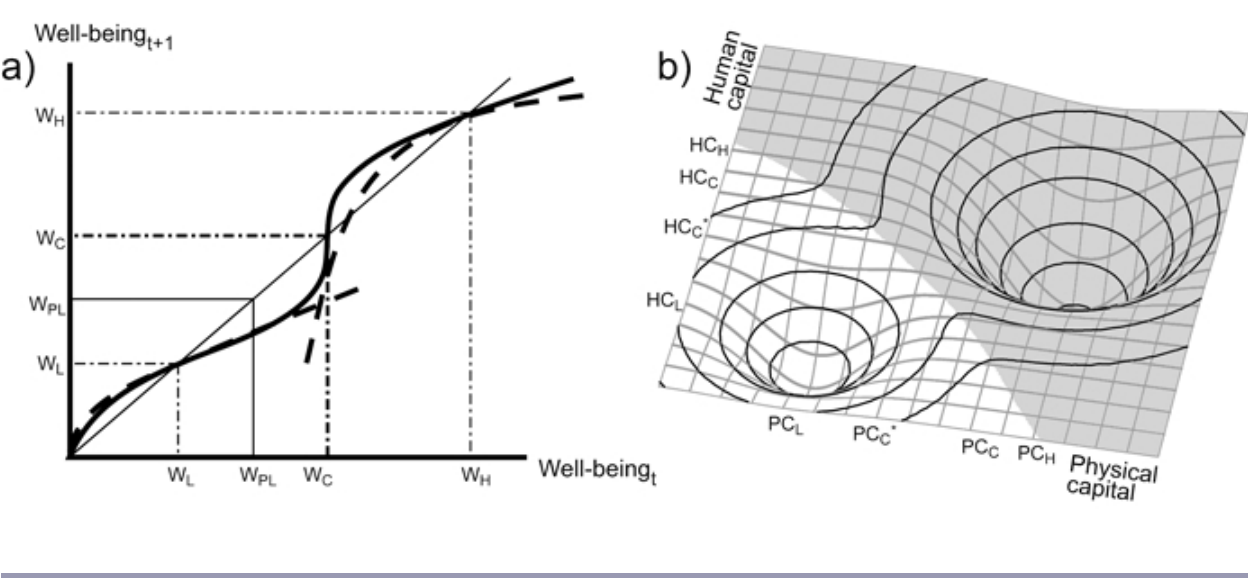
Fig. 3 . Figure 3(a) reproduces Barrett and Swallow’s (2006) figure on well-being dynamics under the poverty trap hypothesis for comparison with the new extended figure provided in 3(b). Figure 3(b) generalizes the approach to multiple forms of capital, which interact to create two self-reinforcing stable states at different equilibrium levels of capital. Vitally, 3(b) illustrates that improvements to either human or physical capital alone may not provide the most effective transition from the impoverished state to the more desirable